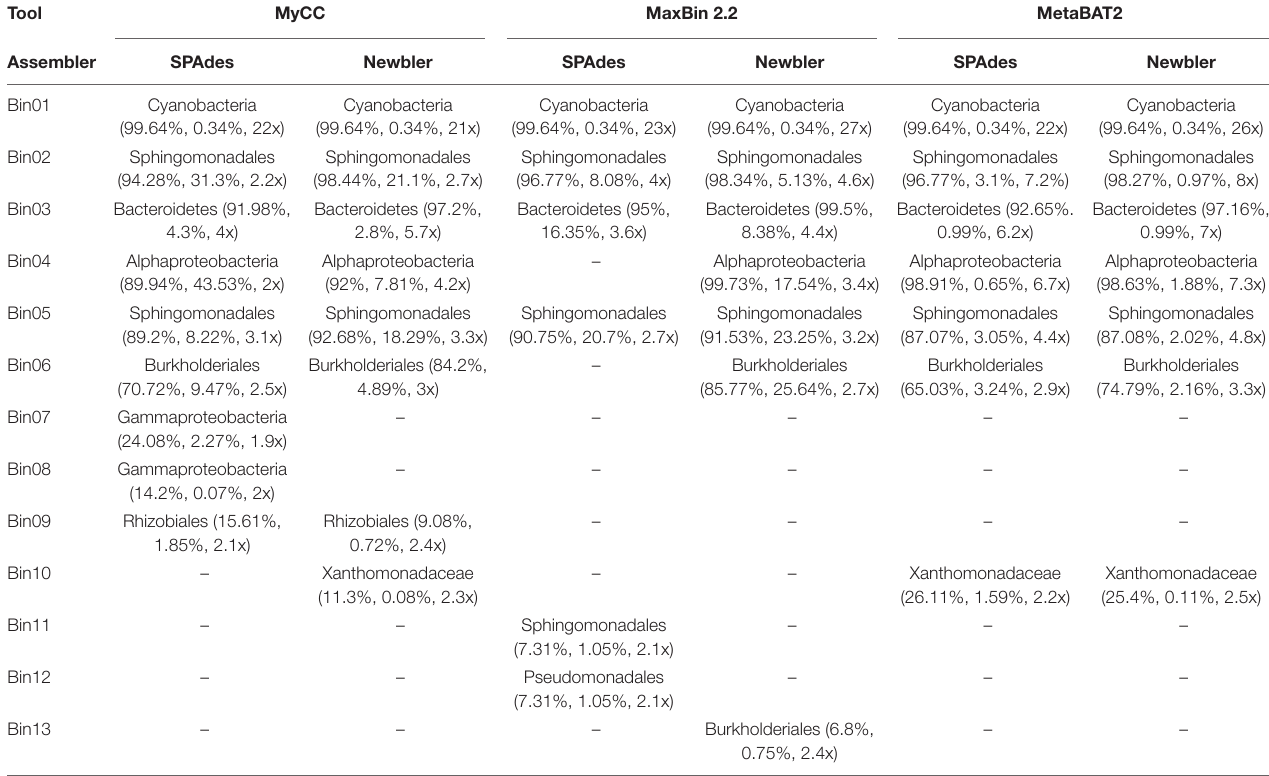
TABLE 1 | CheckM results for each assembler and binning tool.